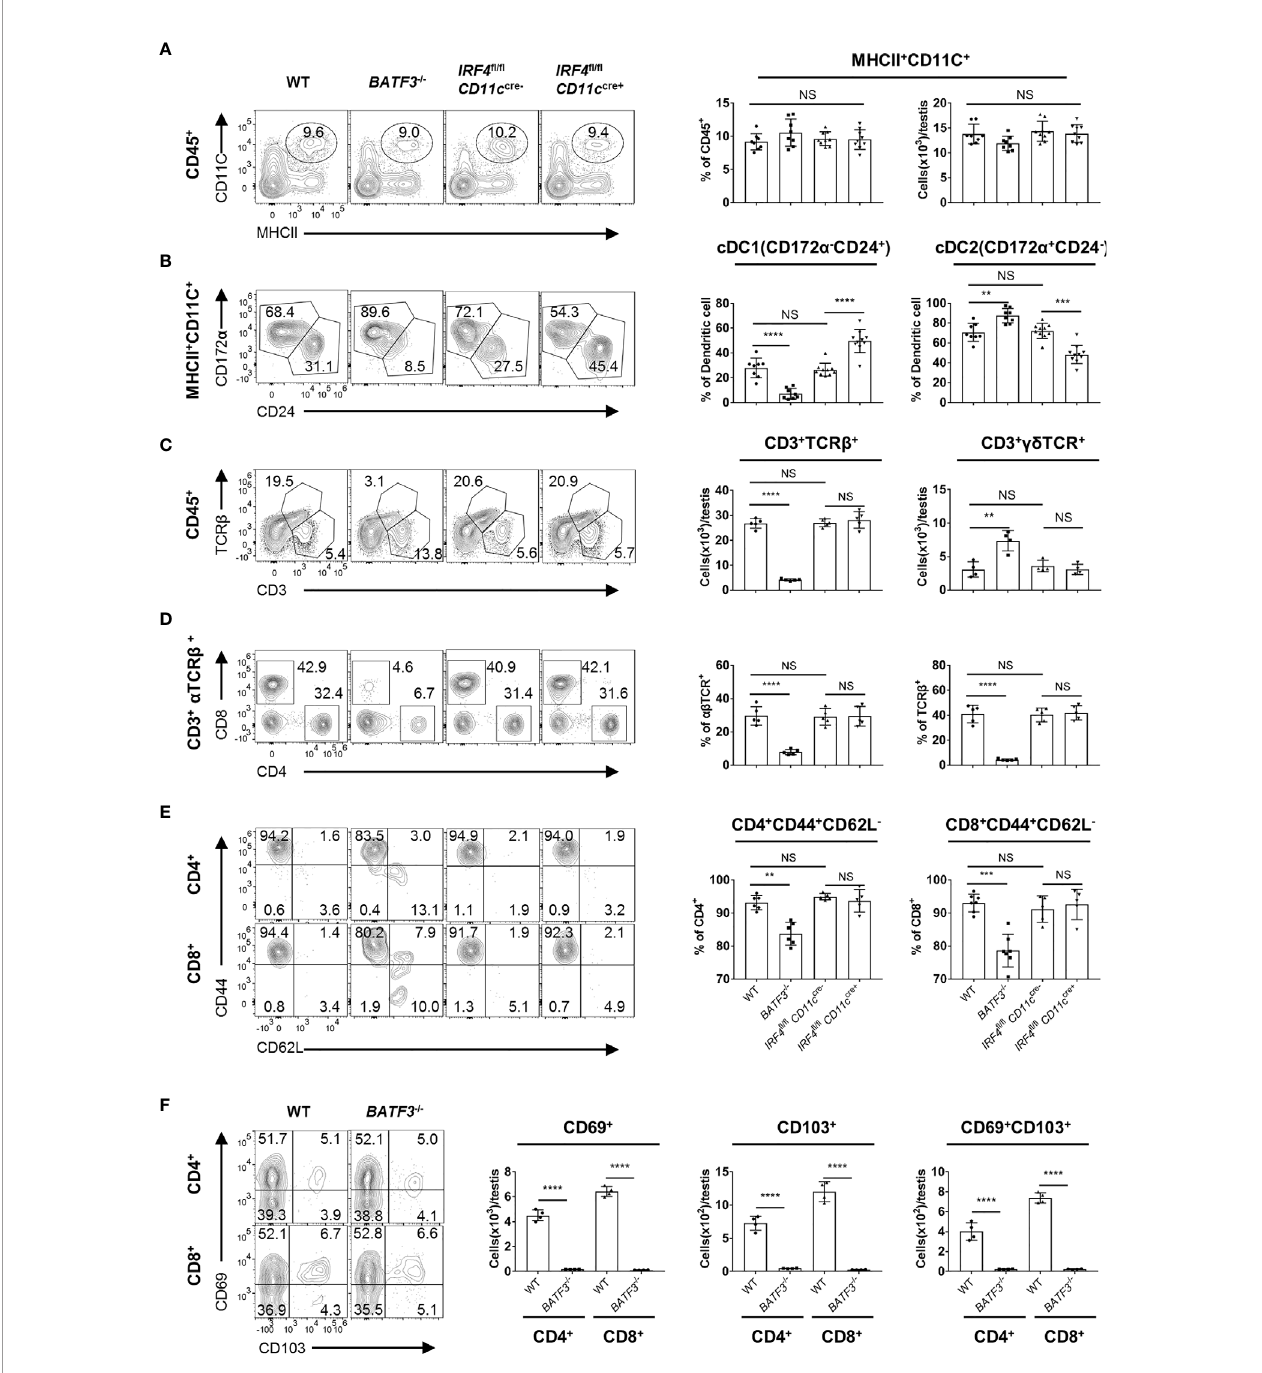
FIGURE 5 | cDC1, but not cDC2, is necessary for the presence of T cells in the testis. (A) FACS analysis of the number and frequency of DC (MHCII + CD11C + ) in the testis from 8-week-old WT, BATF3 − / − , IRF4 fl / fl CD11c cre − , and IRF4 fl / fl CD11c cre+ mice. (B) FACS analysis of the frequency of cDC1 (CD24 + CD172 a − ) and cDC2 (CD172 a + CD24 − ) cells in total DC of the testis from 8-week-old WT, BATF3 − / − , IRF4 fl / fl CD11c cre − , and IRF4 fl / fl CD11c cre+ mice. (A, B) n = 8 – 10. Data were pooled from two experiments (WT and BATF3 − / − mice) and three experiments ( IRF4 fl / fl CD11c cre − and IRF4 fl / fl CD11c cre+ mice). (C) FACS analysis of the frequency and number of ab TCR + T (CD3 + TCR b + ) in the testis from 8-week-old WT, BATF3 − / − , IRF4 fl / fl CD11c cre − , and IRF4 fl / fl CD11c cre+ mice. (D) FACS analysis of the frequency of CD4 + CD8 − and CD4 − CD8 + T cells in CD3 + TCR b + of the testis from 8-week-old WT, BATF3 − / − , IRF4 fl / fl CD11c cre − , and IRF4 fl / fl CD11c cre+ mice. (E) FACS analysis of the frequency of memory (CD44 + CD62L − ) CD4 + and CD8 + T cells in the testis from 8-week-old WT, BATF3 − / − , IRF4 fl / fl CD11c cre − , and IRF4 fl / fl CD11c cre+ mice. (C – E) n = 5 – 6. Data are representative of two experiments. Error bars are the mean ± SD. One-way ANOVA with Tukey ’ s multiple comparisons test for (A – E) and unpaired t test for (F) . **P < 0.01; ***P < 0.001; ****P < 0.0001; NS, not signi fi